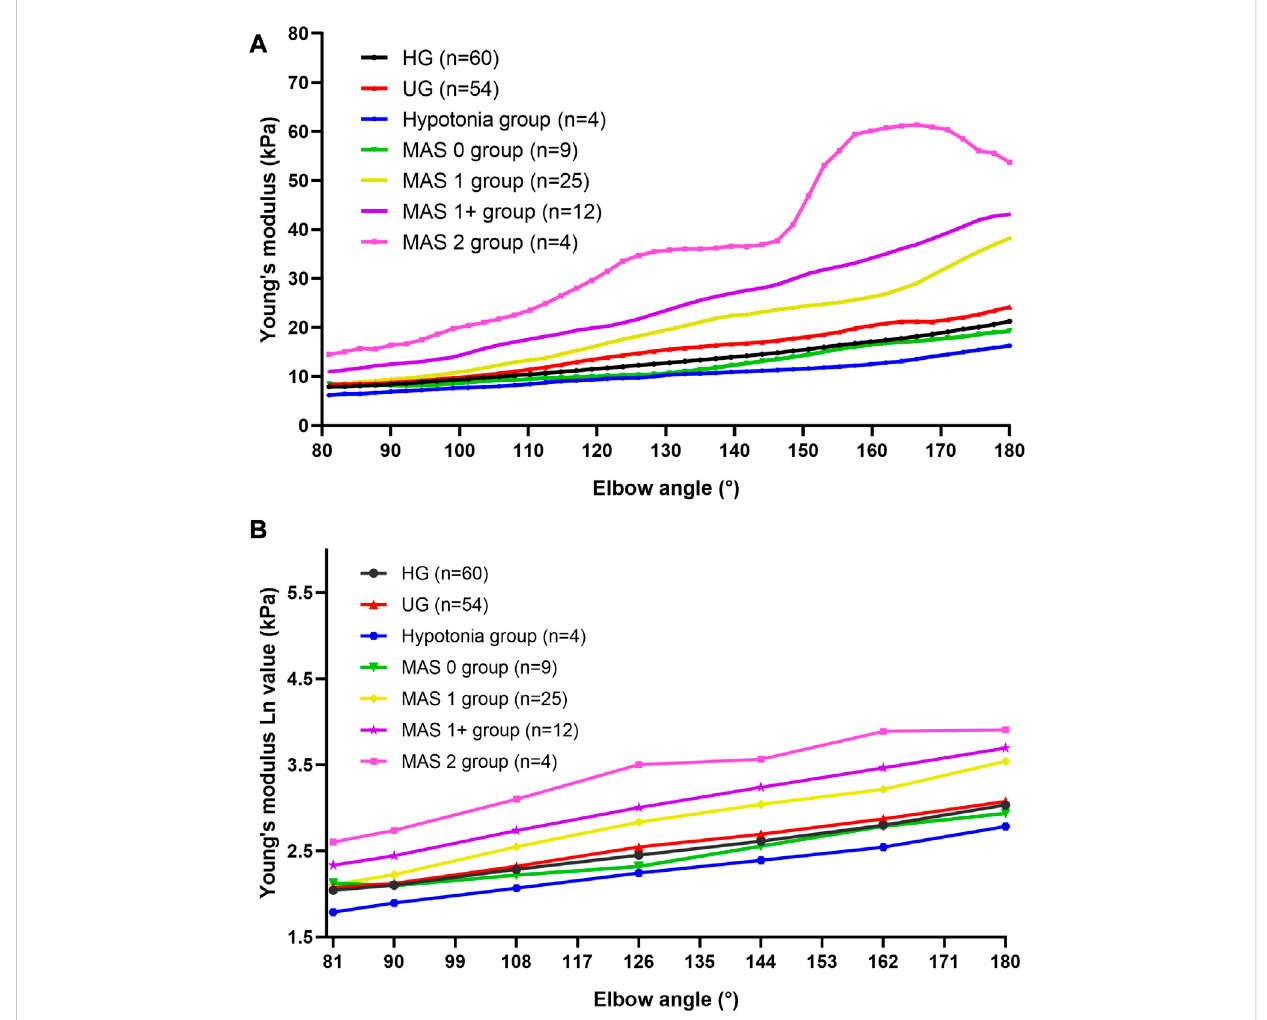
FIGURE 3 Average Young ’ s modulus – angle curves and Ln ( E X )-angle plots of each group. (A) Average Young ’ s modulus – angle curves of each group. The Young ’ s modulus of the biceps brachii gradually increased as theelbow was stretching. In patients with higher MAS, the increase of the Young ’ s modulus occurred earlier and more obviously. (B) Ln ( E X )-angle plots of each group. Abbreviations: HG, healthy volunteer group; MAS, modi fi ed Ashworth scale; UG, unaffected side of